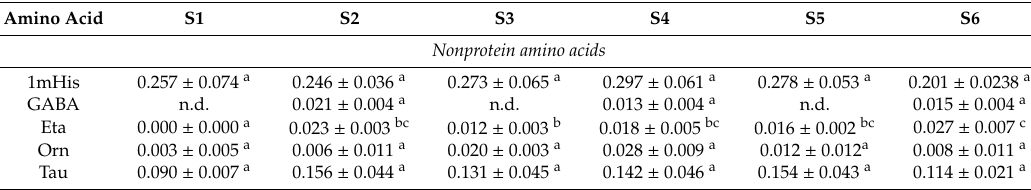
Table 2. Amino acid content in sous vide beef steak (mg kg − 1